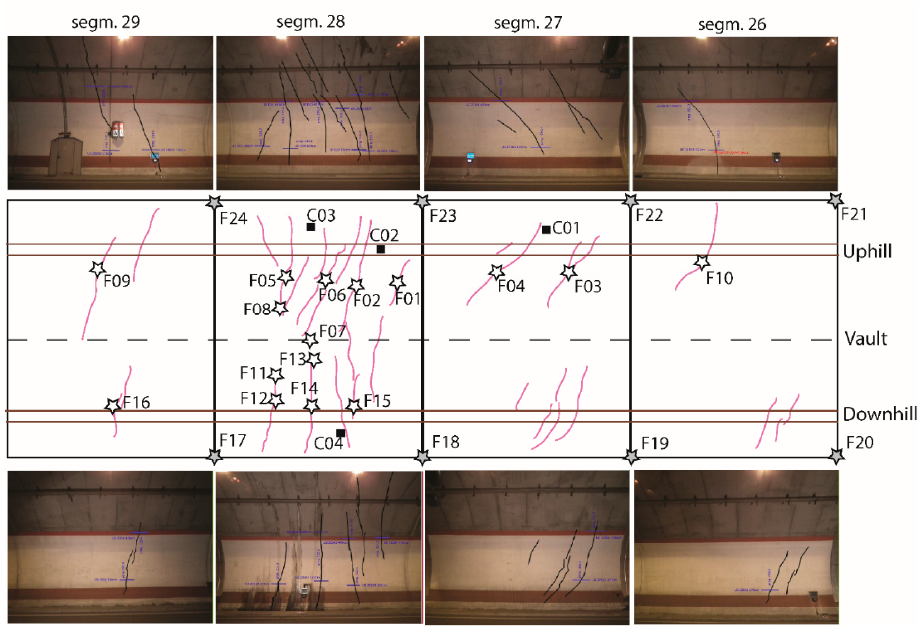
Figure 4. Distribution of tension cracks along the tunnel: the white stars refer to the crackmeters deployed along cracks, the grey stars to the crackmeter deployed between the segments and the black squares to the two-axis clinometers. The area comprises the section of the tunnel between 261 and 309 m from the eastern entrance.